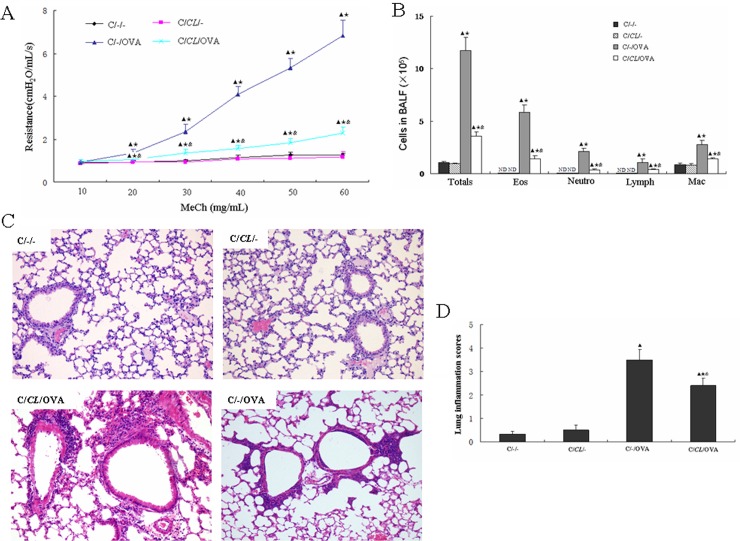
Early-life fed-CL reduced airway responsiveness, BALF cell numbers, and inflammatory cell infiltration in CD asthma mice.(A) AHR determined by airway resistance in response to inhaled methacholine (MeCh). (B) Total cell numbers and differential eosinophil (Eos), neutrophil (Neutro), lymphocyte (Lymph), and macrophage (Mac) counts in BALF. Lung tissue sections were stained with hematoxylin–eosin to evaluate allergic inflammation. (C) Representative images of lung tissue sections (original magnification, ×400). (D) Scoring of the extent of inflammation via quantitative analysis of inflammatory cell infiltration in lung sections. Data are plotted as the means ± SD. ▲
p < 0.05 vs. C/-/-; ★
p < 0.05 vs. C/CL/-; &
p < 0.05 vs. C/-/OVA.